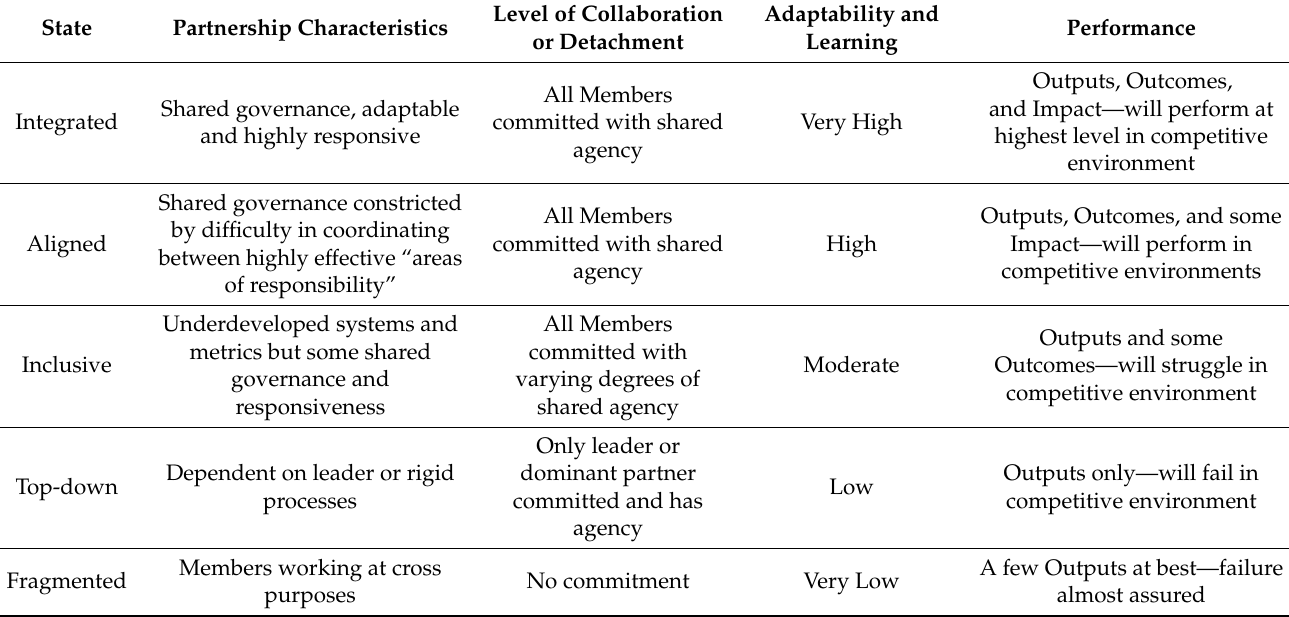
Table 2. Summary of x-axis and relationship with performance of the Cooperative Capacity Ladder.